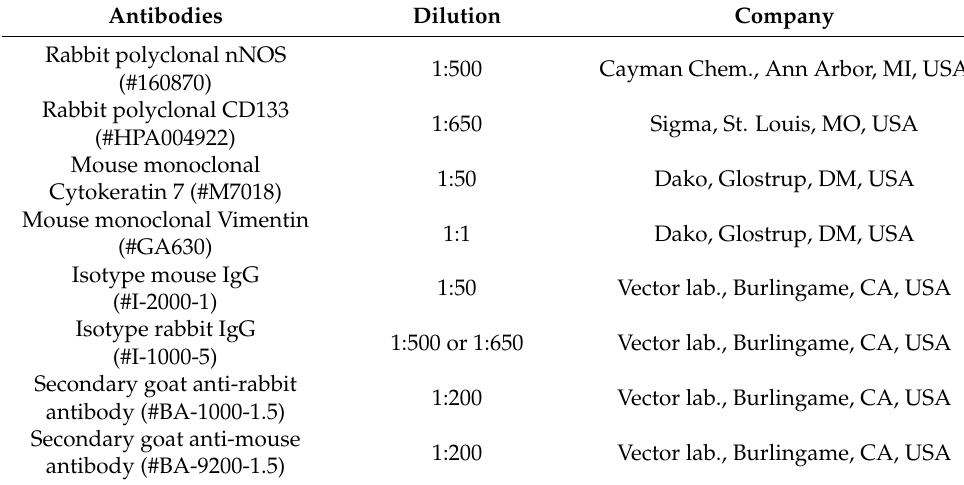
Table 2. Antibodies used in this